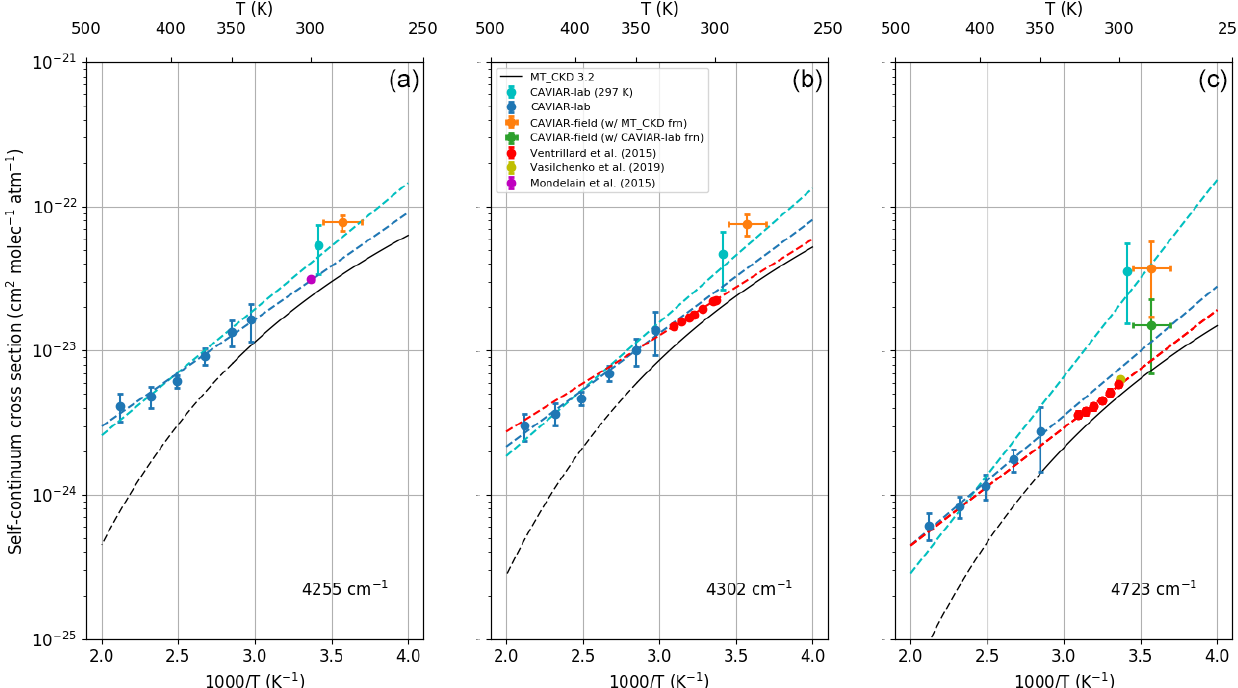
Figure 14. Self-continuum absorption cross section against temperature for various datasets at (a) 4255, (b) 4302, and (c) 4723cm − 1 . The error bars indicate the k = 1 uncertainties. Marker size is greater than the stated uncertainty where error bars are not visible. The dashed line of MT_CKD above 350K indicates the region outside of the expected applicability of MT_CKD. The dashed blue, cyan, and red lines indicate extrapolations of the CAVIAR-lab (with and without the low-temperature data) and Grenoble temperature dependence respectively, assuming an exponential temperature dependence. The green data points (CAVIAR-field with CAVIAR-lab foreign continuum) are missing from frames (a) and (b) as the inferred self-continuum is